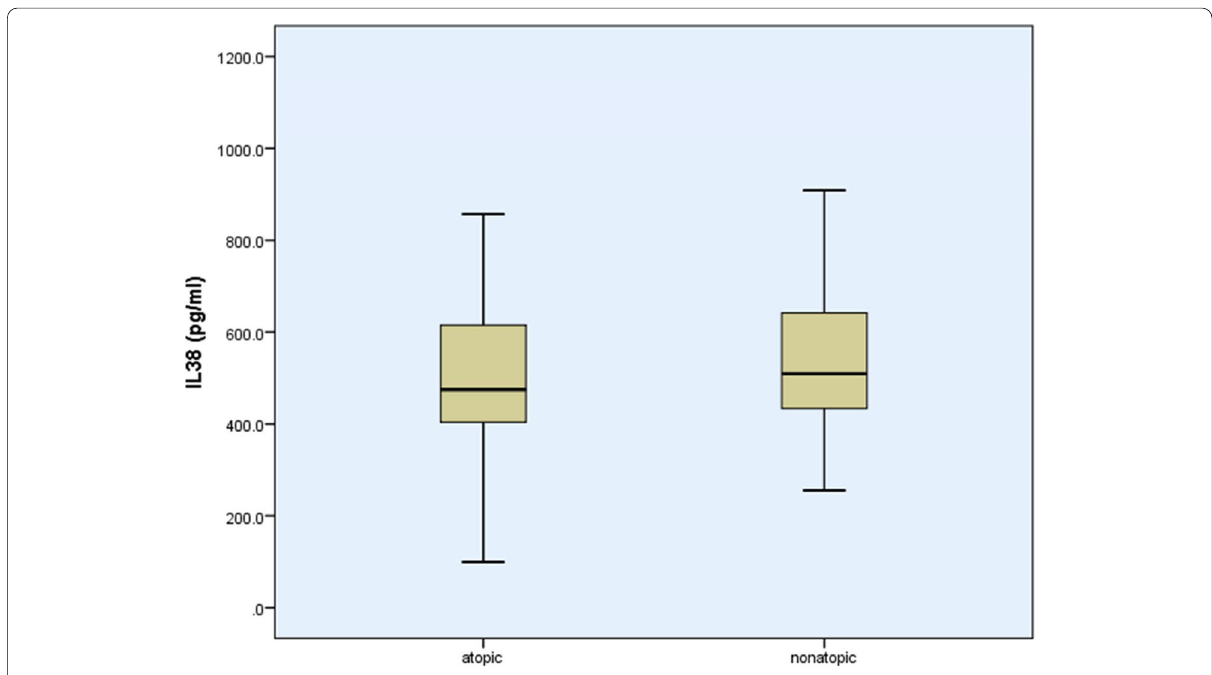
Fig. 2 IL-38 serum levels in atopic and non-atopic asthmatic patients